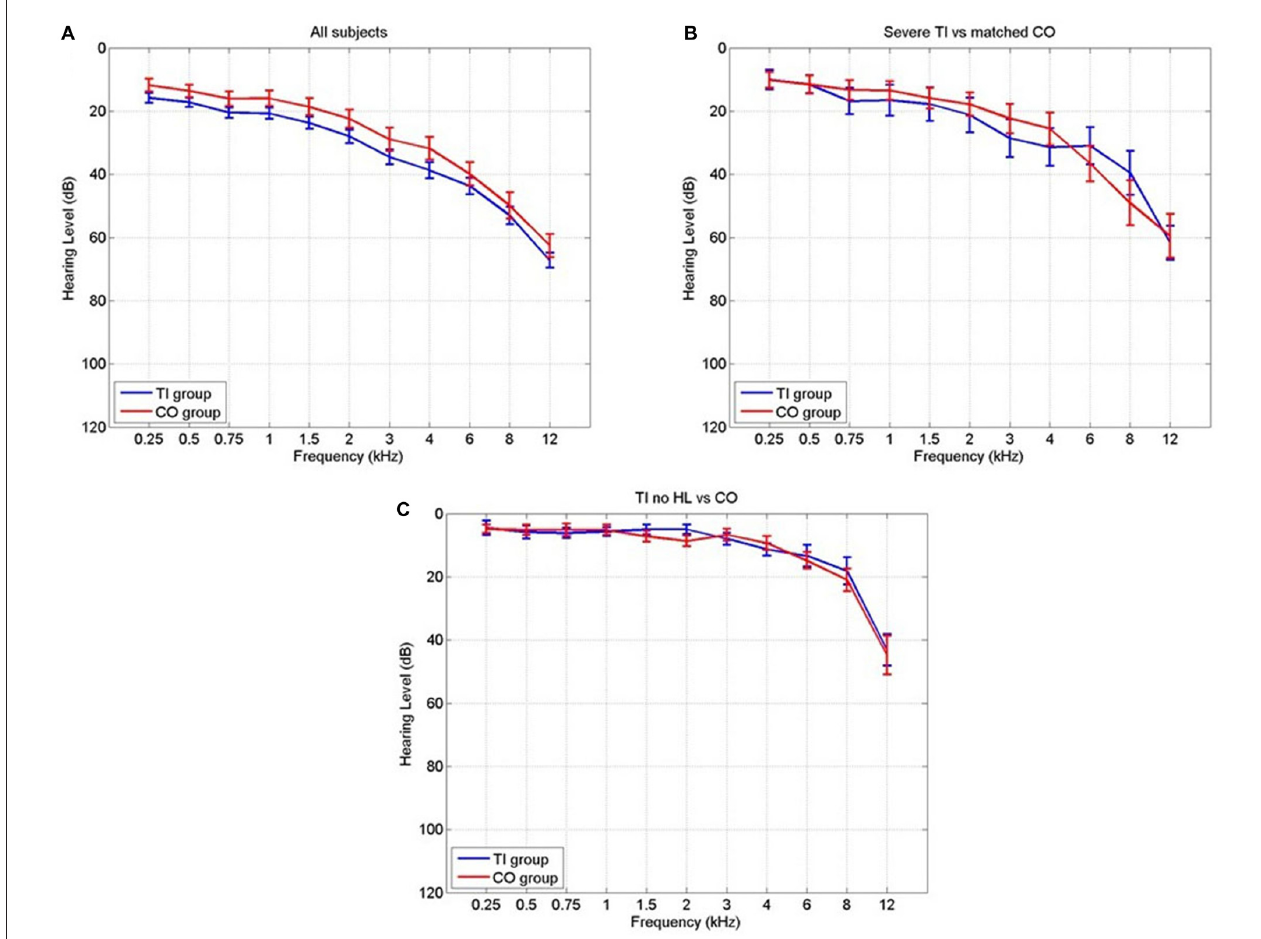
FIGURE 1 | The audiograms for each comparison group for the tinnitus participants (blue) and the controls (red) in (A) all subjects, (B) severe tinnitus and matched controls and (C) tinnitus with no hearing loss and matched controls.